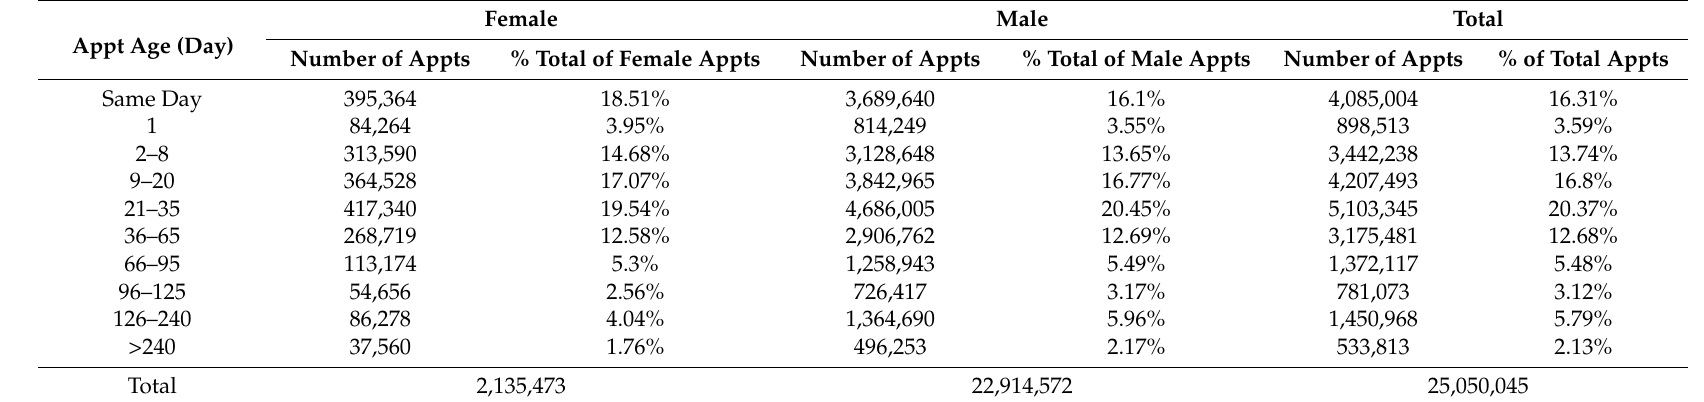
Table 4. Appointment frequencies and percentages by gender for appointment age groups.